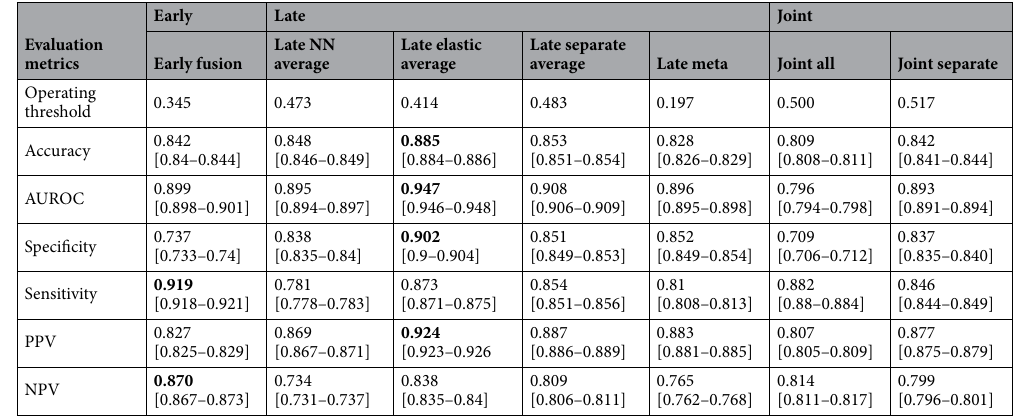
Table 2. Fusion model architecture experimentation. Comparison between different fusion strategies. Model performance on the held-out test set with 95% confidence interval using probability threshold that maximizes both sensitivity and specificity on the validation dataset. Best performance metrics in bold text.